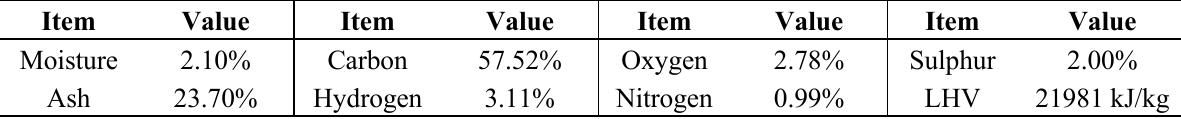
Table 1. Approximate analysis of coal (wt. %; as